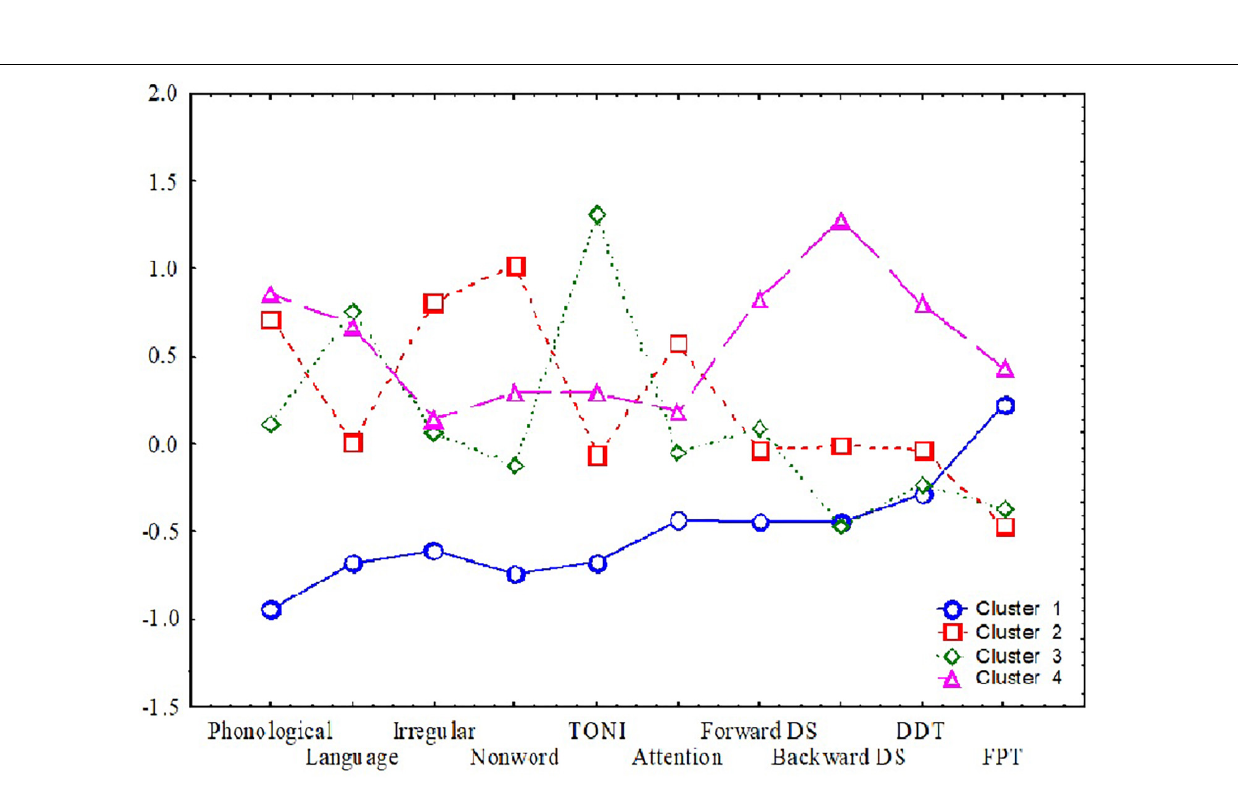
Frontiers in Psychology |